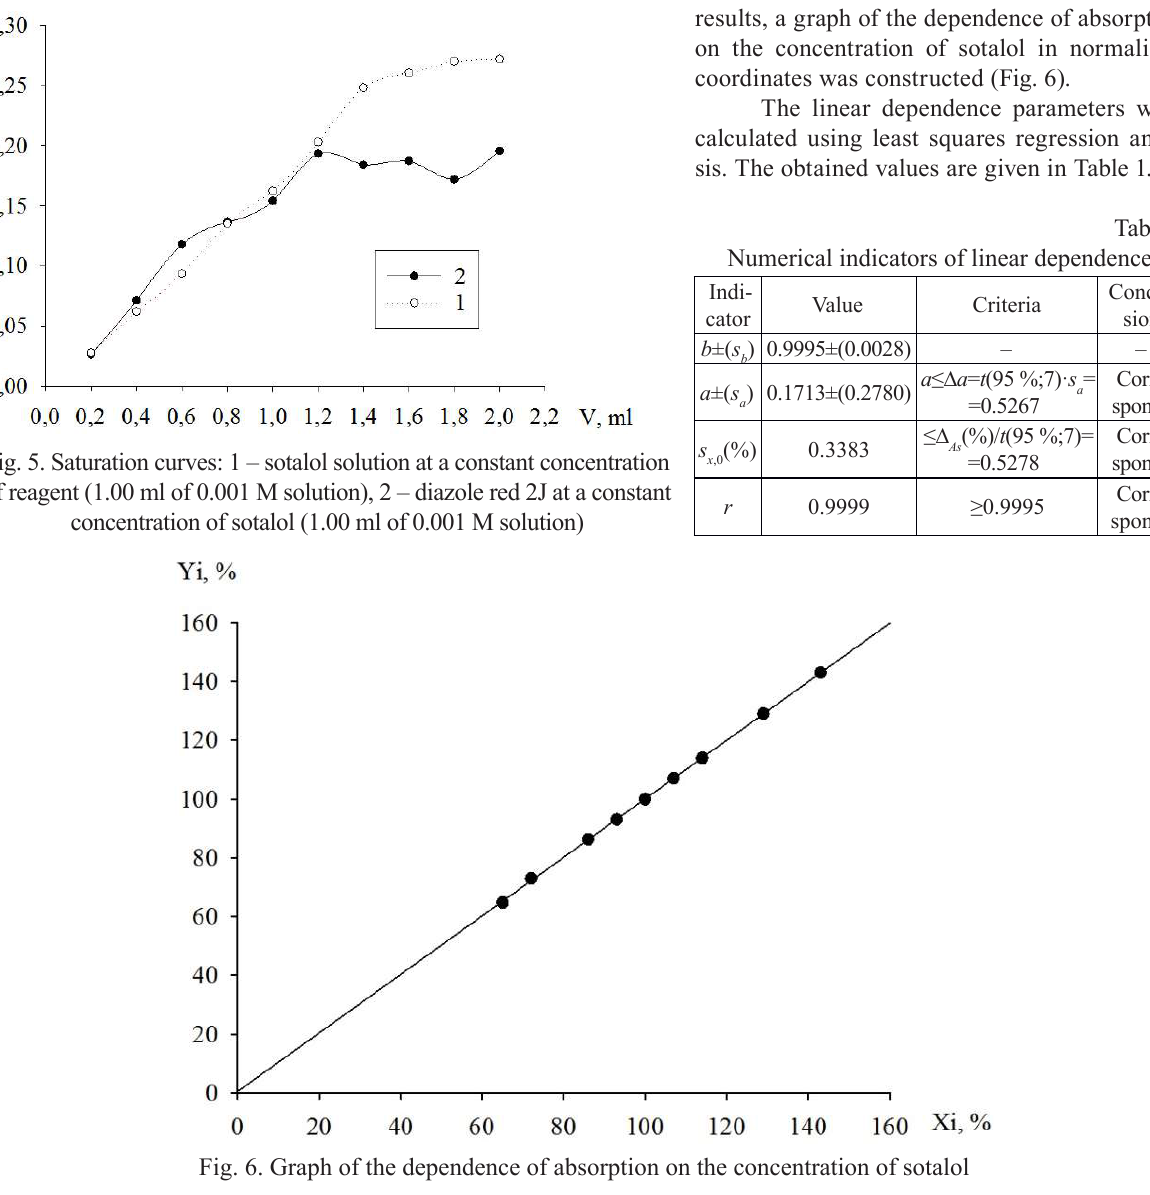
Fig. 6. Graph of the dependence of absorption on the concentration of